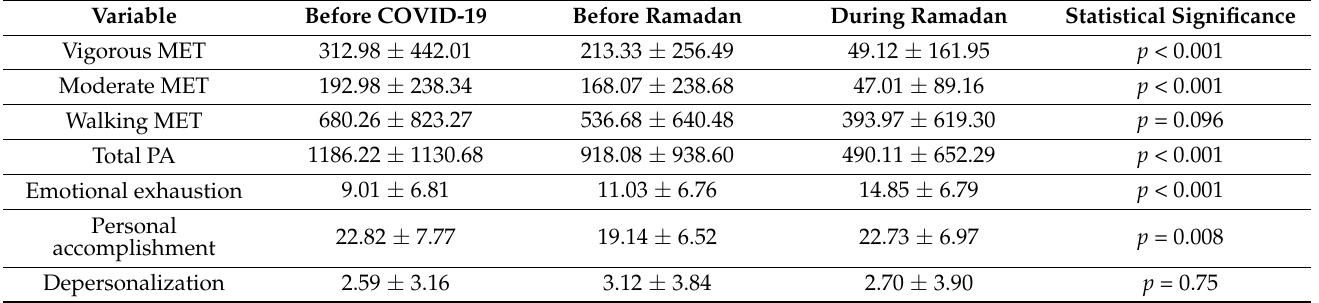
Table 1. Values of physical activity and burnout subscales, broken down according to the